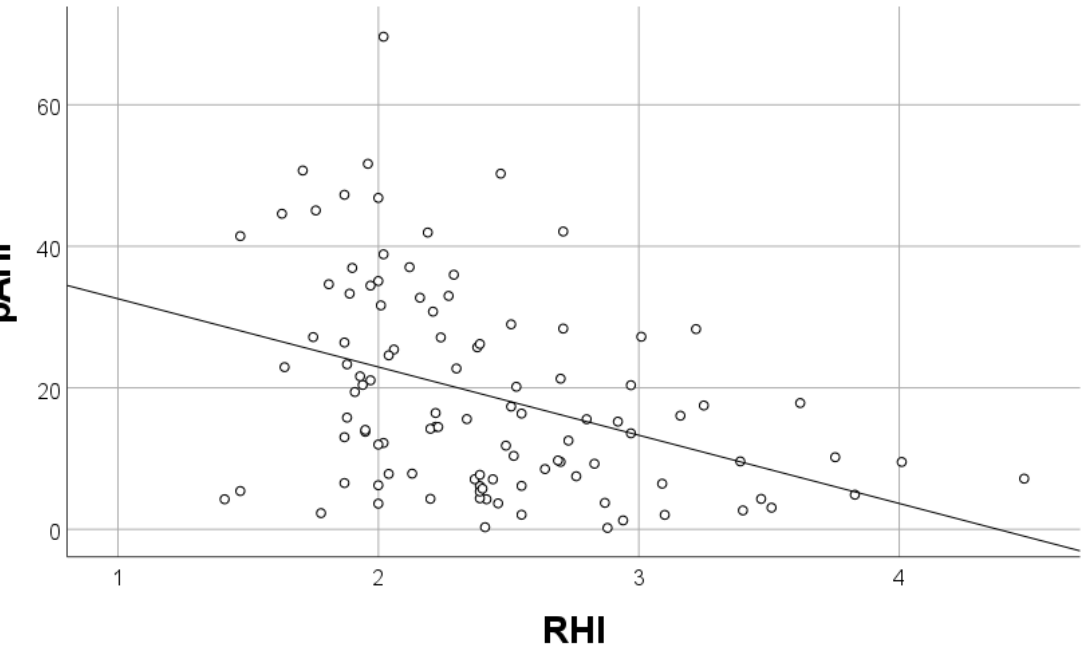
Figure 2. Correlation of peripheral artery tone acquired apnea/hypopnea index (pAHI) and reactive hyperemia index (RHI) values R= −0.387; p < 0.001.